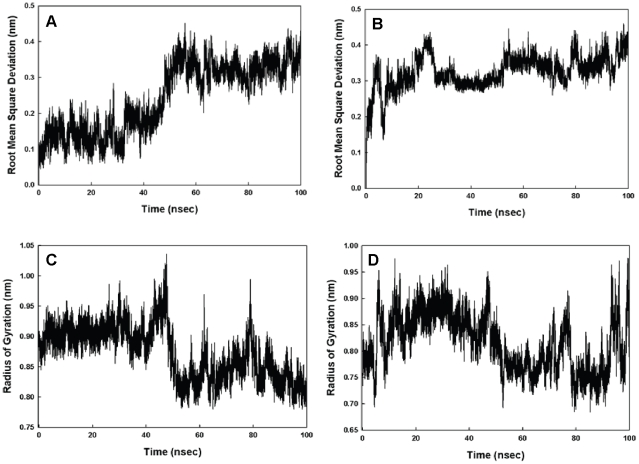
Time dependent stability studies.Panel A shows Root Mean Square Deviation (RMSD) of the C-α carbons for D-4F. Panel B shows these RMSD values for OxP-11D. Panel C shows the radius of gyration for D-4F and Panel D shows the radius of gyration for OxP-11D. All values are shown as a function of time (in nanoseconds) and come from molecular dynamic studies in a simulated HFIP:buffer (6∶4) environment.